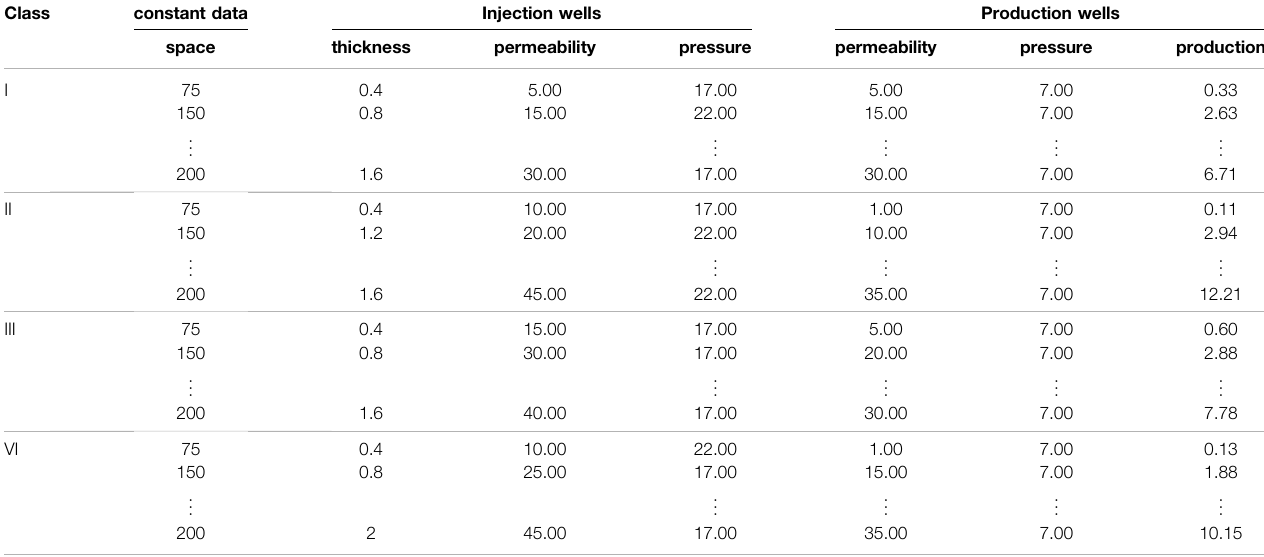
TABLE 2 | Basic data sets of different permeability con fi gurations (part).